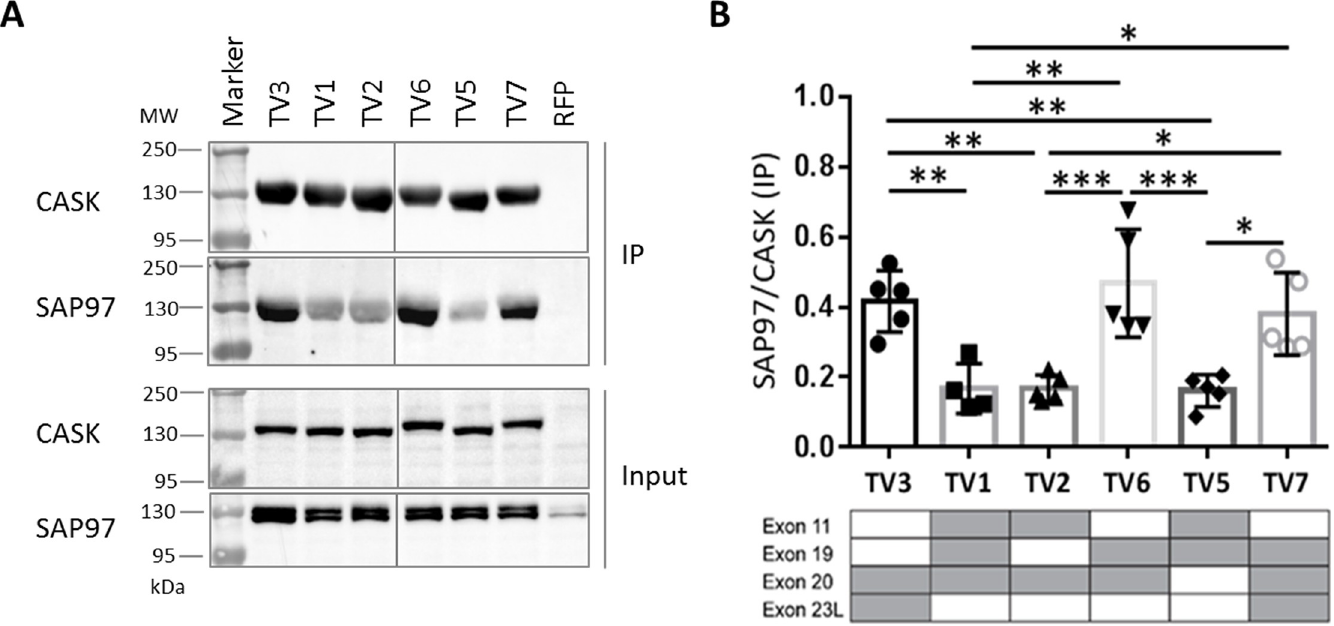
Fig 6. The absence of splice insert encoded by exon 11 in CASK variants results in stronger SAP97 binding. A: HEK293-T cells expressing RFP-CASK variants (TV1-TV7; TV4 not present) or RFP together with Myc-tagged SAP97 were lysed in RIPA buffer, and RFP-tagged CASK proteins were immunoprecipitated by RFP-Trap. Input and immunoprecipitate (IP) samples were analysed by Western Blot, using α -CASK and α -Myc antibodies. All samples were run and analyzed on the same gel/blot, and intervening lanes with non-relevant samples are not shown. B: The binding affinity of each CASK variant was determined as ratio of SAP97 over CASK IP. The presence of alternative exons is indicated by grey colour in tables below the respective bar graphs. Note that all CASK variants lacking the splice insert encoded by exon 11 showed a significantly increased binding strength to SAP97, compared to the variants without splice insert 11. Data are shown as means +/-SD. � P � 0.05, �� P � 0.01, ��� P � 0.001, One-way ANOVA followed by Tukey’s multiple comparisons test with n = 5.